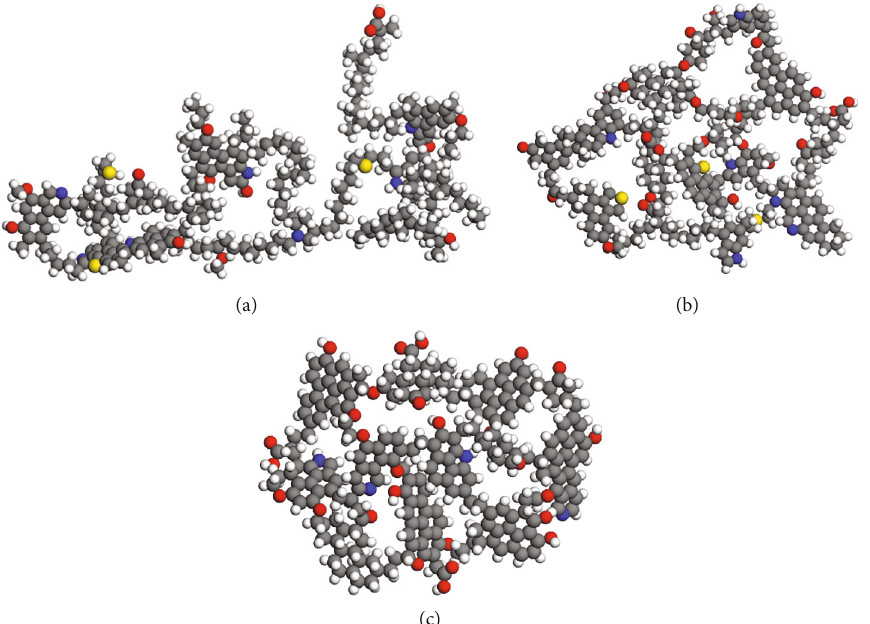
H O N S ; (b) the type-II kerogen 251 385 13 7 3